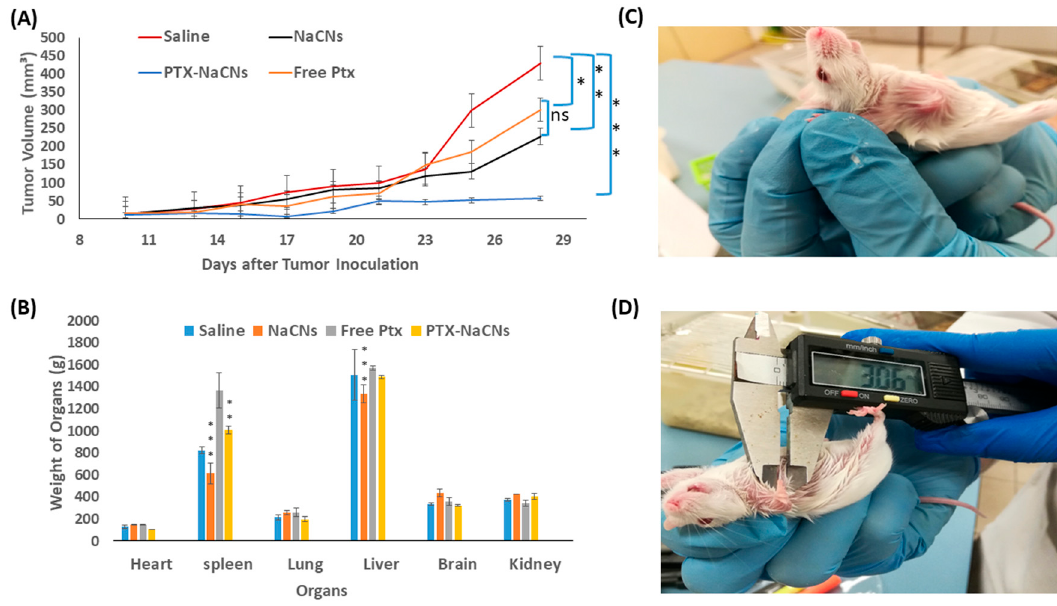
Figure 15. In vivo anti-tumor efficacy showing ( A ) mean tumor volume (mm 3 ) of negative control, NaCNS, free PTX and PTX-NaCNs-treated groups throughout the study period following tumor inoculation and ( B ) the mean weight of the vital organs of negative control, NaCNs-, free PTX and PTX-NaCNs- treated groups on day 28 after the mice were sacrificed via cervical dislocation. ( C ) Murine breast cancer model selected to evaluate the anti-tumor efficacy of PTX-NaCNs. ( D ) Tumor measurement using a digital Vernier calliper [values are significant (*) at p < 0.05, very significant (**) at p < 0.01 and highly significant (***) at p < 0.001].